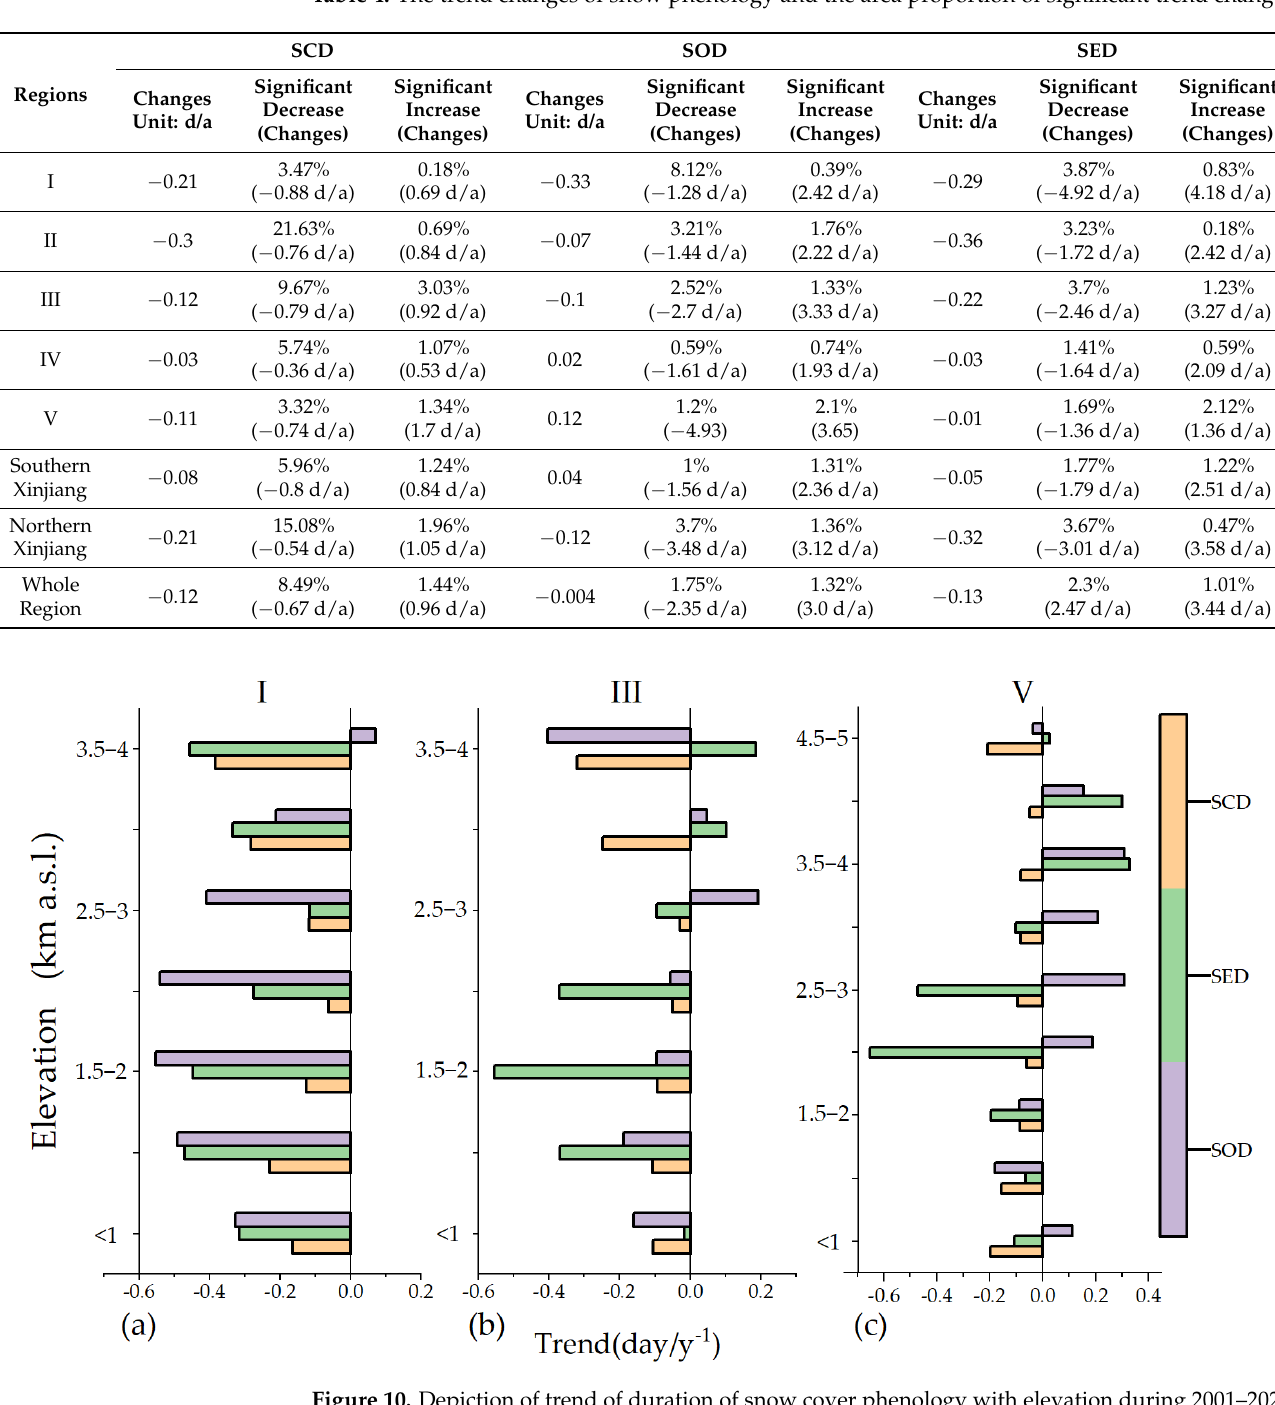
Table 4. The trend changes of snow phenology and the area proportion of significant trend change.